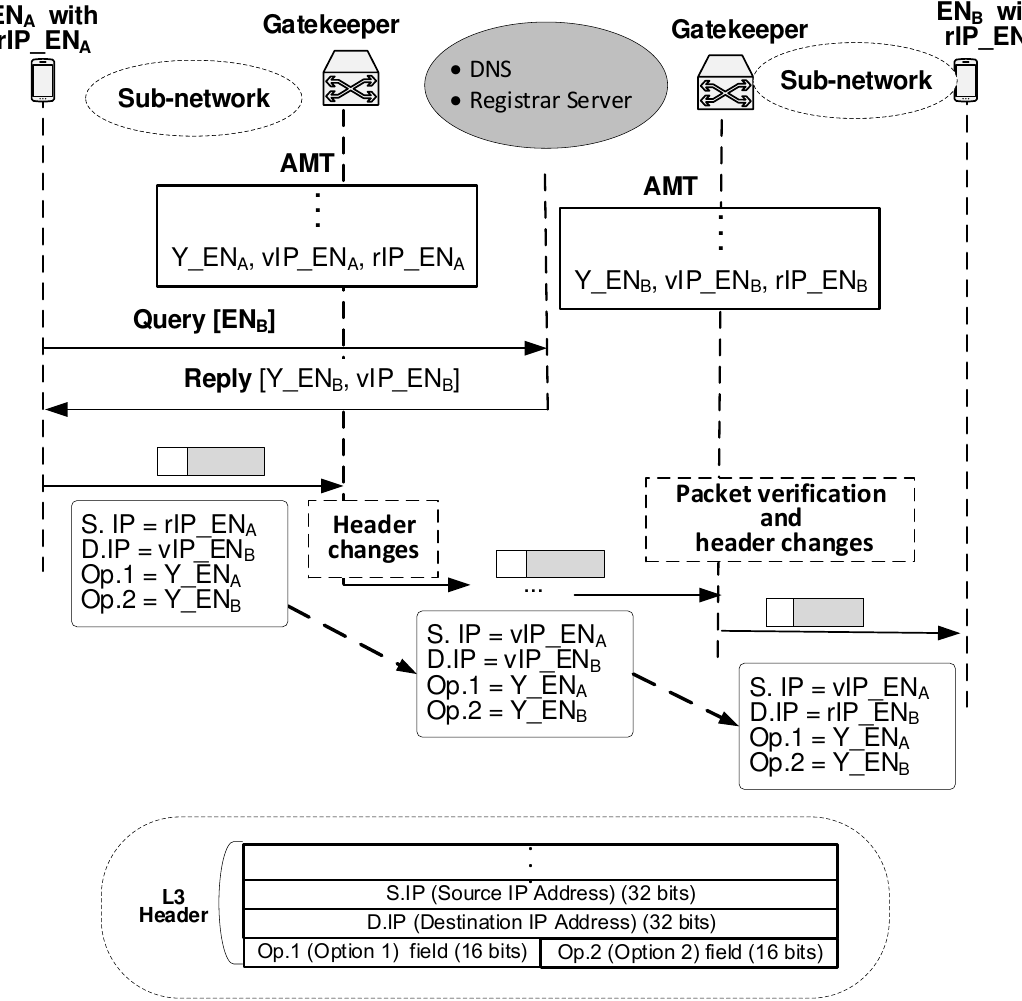
Figure 3. Verification of passing packets and IP header conversion of passing packets through the